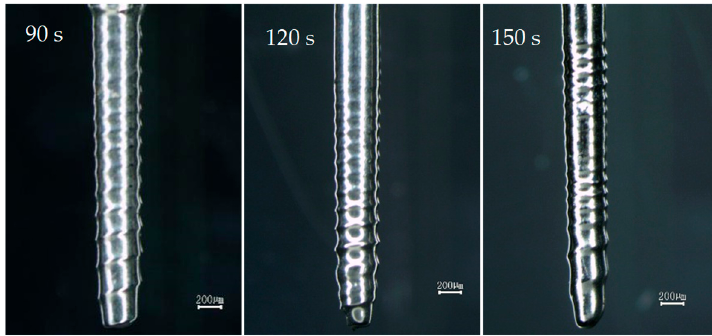
Figure 9. The spiral cylindrical microelectrodes fabricated at different machining times.